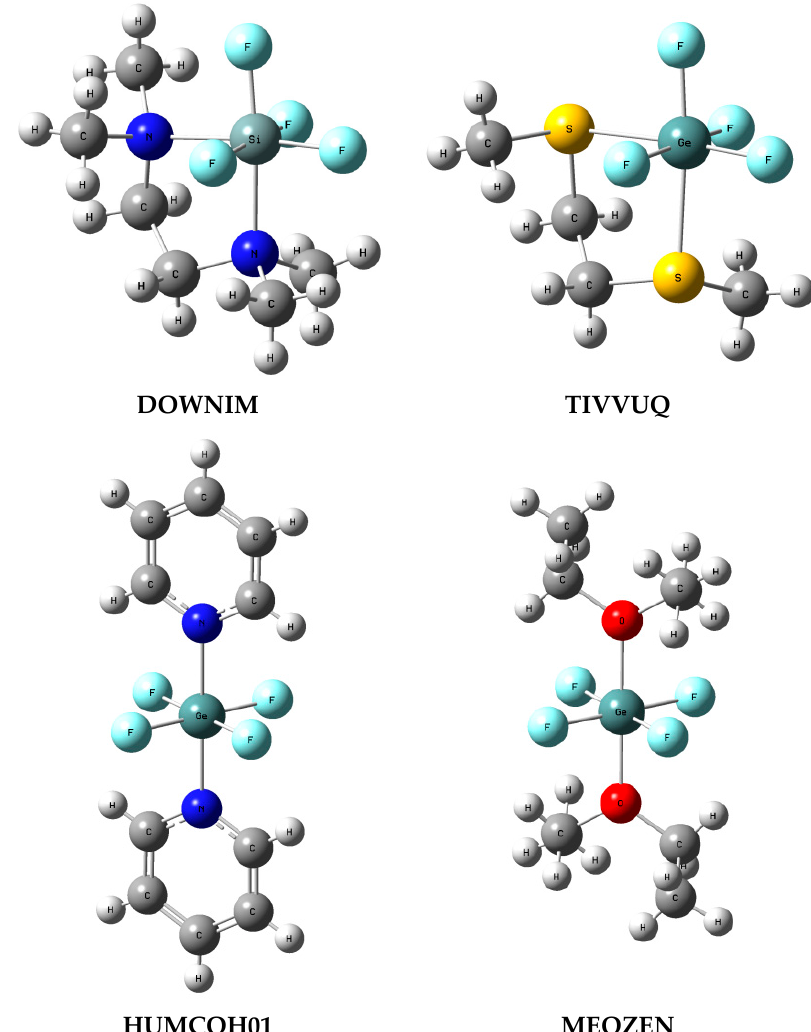
Figure 5. Examples of crystal structures containing hexacoordinated Si or Ge centre, the SiF 4 L 1 L 2 and GeF 4 L 1 L 2 arrangements are considered (L 1 and L 2 —ligands connected with Si or Ge by the Groups 15 and 16 element); the Cambridge Structural Database Refcodes are shown.